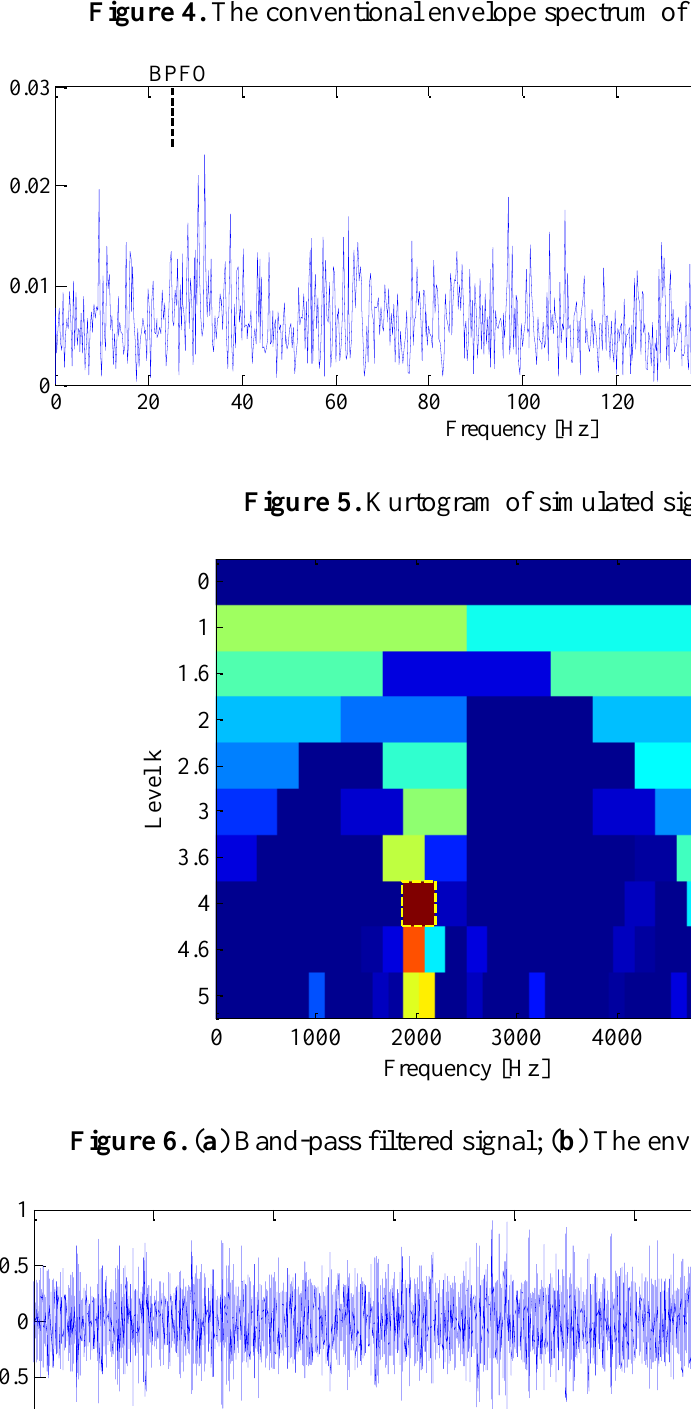
Figure 4. The conventional envelope spectrum of simulated signal.